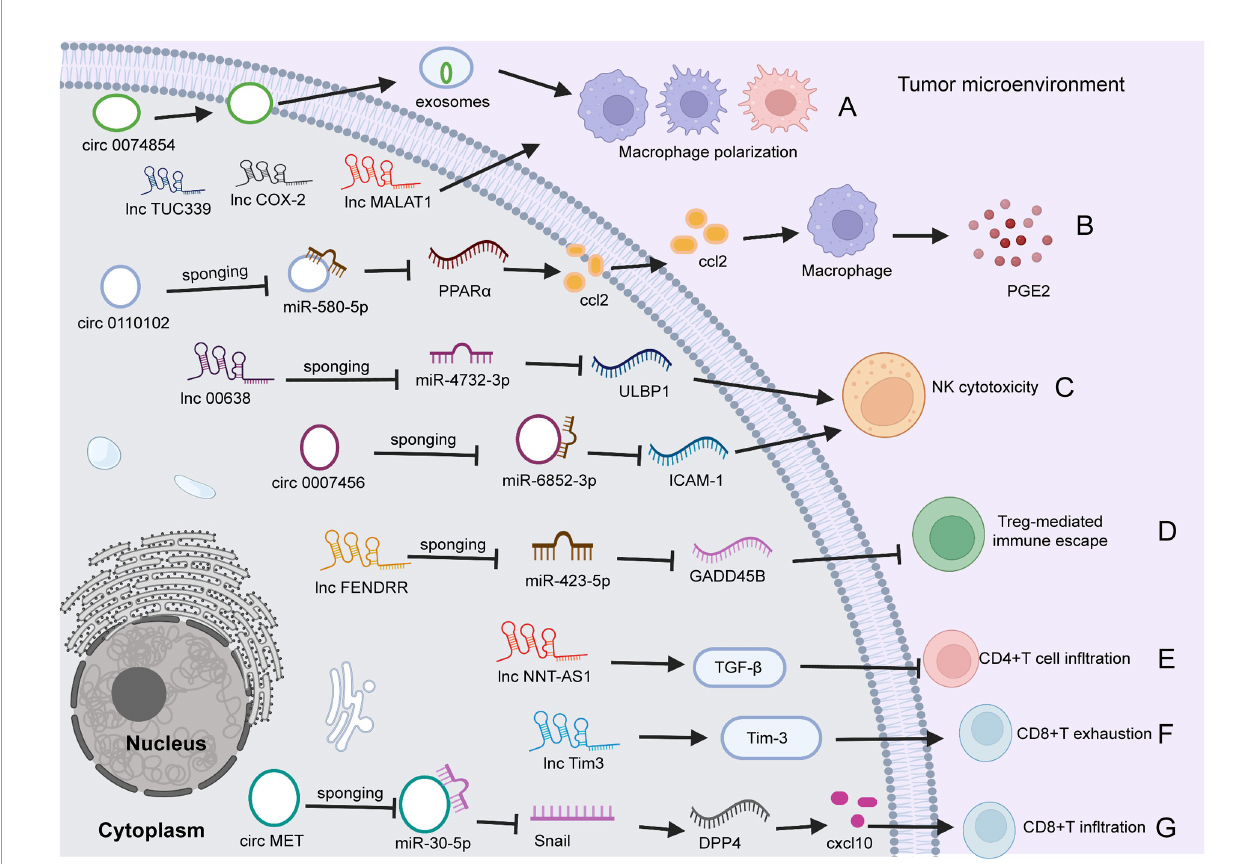
FIGURE 2 | The role of circRNAs and lncRNAs in regulating HCC immunity. (A) circ0074854 in exosomes transfers from HCC cells to macrophages, regulating macrophage polarization. Besides, lncTUC339, lncCOX-2, and lncMALAT1 involve in macrophage polarization. (B) Upregulated circ0110102 promotes CCL2 secretion into the TME by reducing the level of PPAR a by sponging miR-580-5P in HCC cells, leading to macrophage secretion of proin fl ammatory PGE2. (C) circ0007456 is downregulated in HCC cells and regulates NK cytotoxicity by mediating ICAM-1 expression by sponging miR-6852-3P. Similarly, lnc00638/miR- 4732-3p/ULBP1 axis regulates NK cell cytotoxicity. (D) lncFENDRR acts as a miR-423-5p sponge to suppress the Treg cell mediated immune escape. (E) . lncNNT- AS1 activates TGF- b signaling to decrease tumor CD4+T cell in fi ltration. (F) Lnc-Tim3 exacerbates CD8 T cell exhaustion via binding to Tim-3. (G) circ MET is upregulated in HCC tumors, and overexpressed circMET facilitates CD8+T cells in fi ltration through the miR-30-5p/Snail/DPP4/CXCL10 axis. TME, tumor microenvironment; circRNA, circular RNA; PPAR a , peroxisome proliferator-activated receptor a ; miR, microRNA; DPP4, dipeptidyl peptidase 4; NK, natural killer; ICAM-1, intercellular adhesion molecule 1; PGE2, Prostaglandin E2; NK, natural killer; ICAM-1, intercellular adhesion molecule-1; ULBP1, UL16-binding protein 1; Treg, regulatory; TGF, Transforming growth factor; DPP4, dipeptidyl peptidase; CXCL10, CXC chemokine ligand